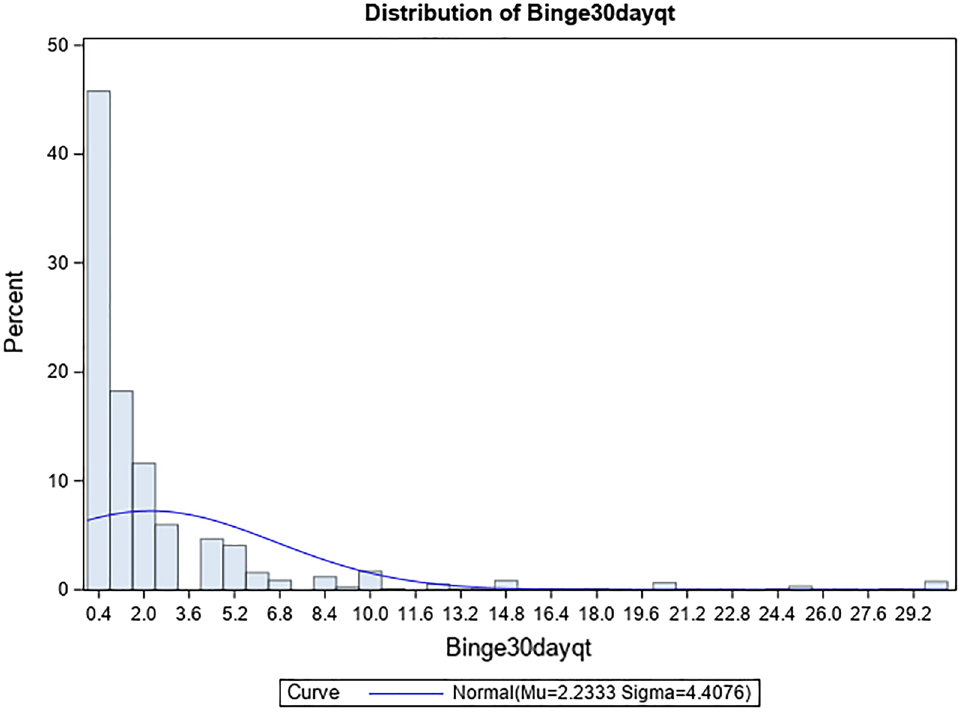
Figure 1. Histogram of number of days of binge drinking in the past month among 2018 NSDUH adult